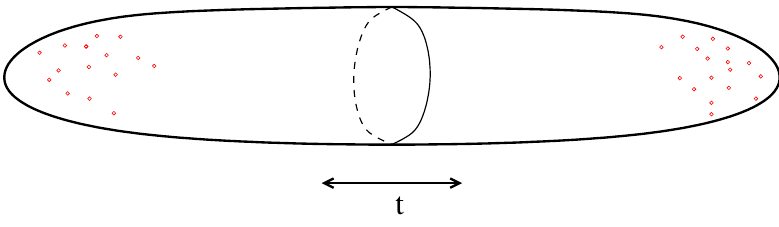
Figure 2 . In the degeneration limit of a K 3 (cid:12)bred Calabi-Yau threefold X (cid:12)bres are localized towards the two ends of the elongated base. Cutting along the S 1 in the middle, we obtain the (open versions of) the building blocks Z